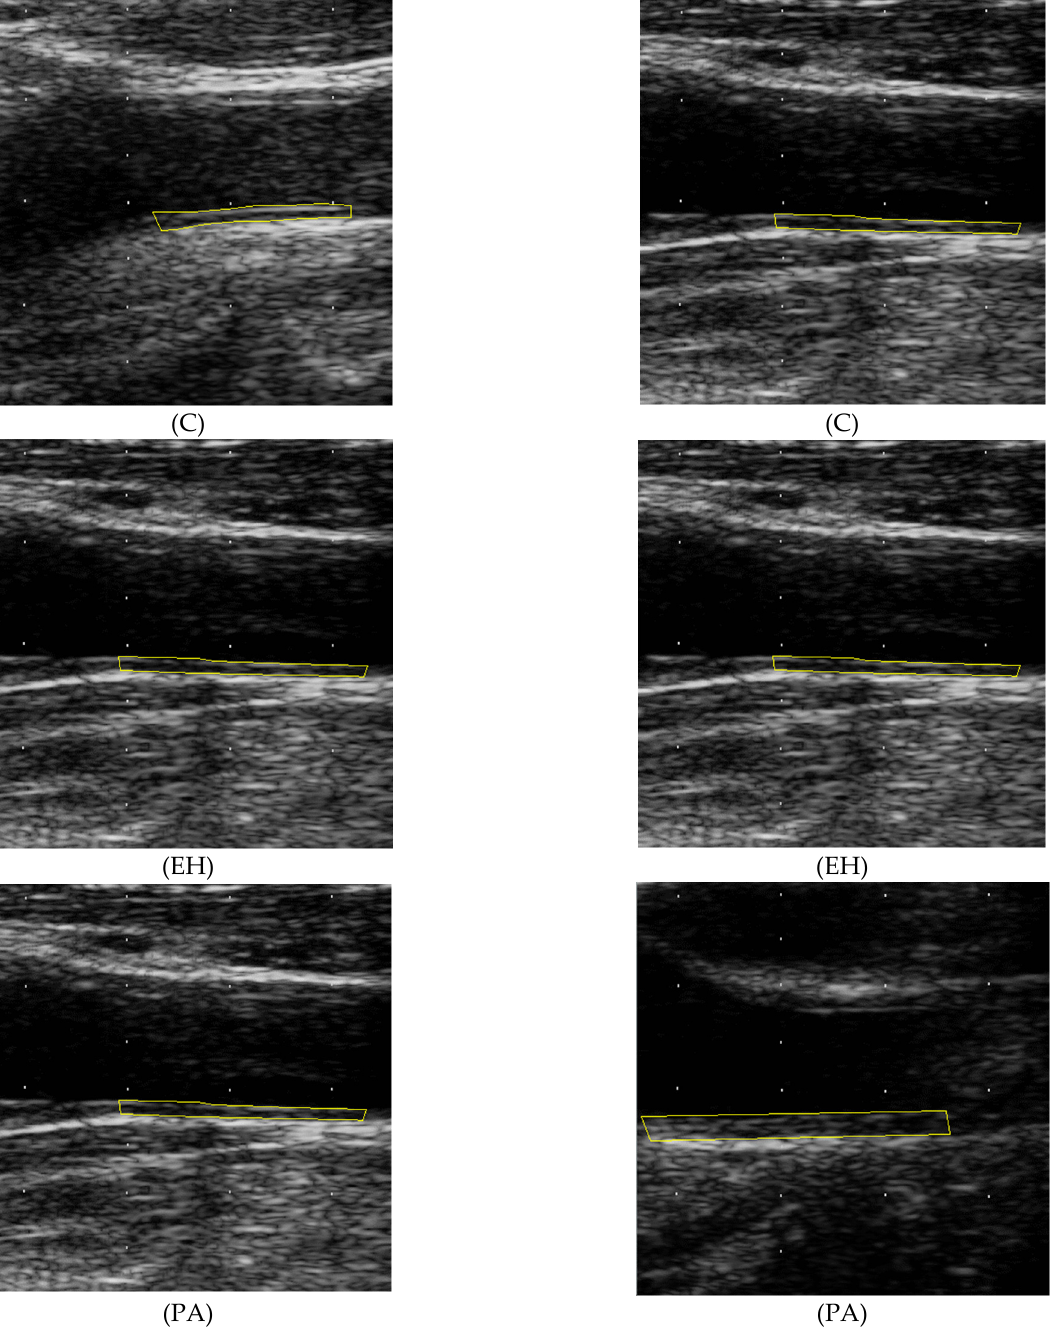
Figure 3. Example longitudinal carotid artery ultrasound images: healthy controls (C), patients with essential hypertension (EH), and primary aldosteronism (PA). The intima-media region of interest (ROI) on the left and right side is marked in yellow.